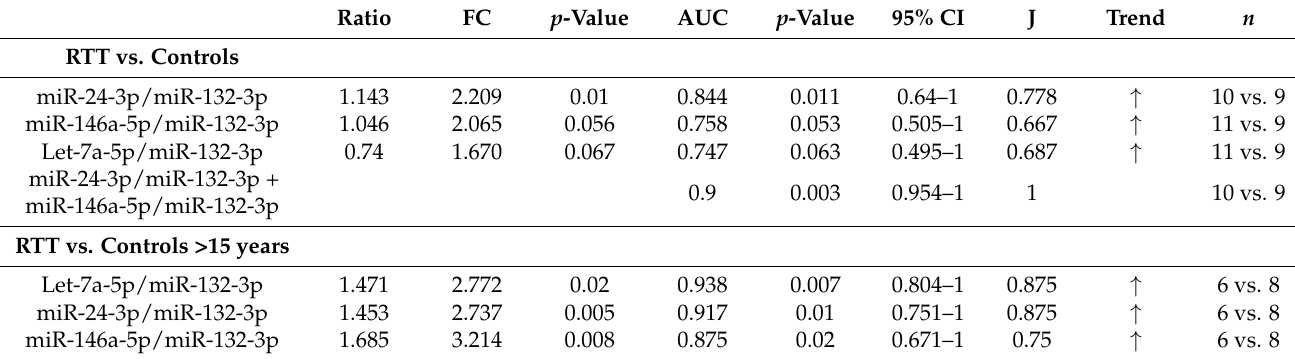
Figure 2. Potential microRNA (miRNA) biomarkers for RTT detection. ( A ) Heat map of Spearman correlation between miRNA expressions in plasma; 1 is positive correlation, 0 no correlation and − 1 is negative correlation. Statistically significant correlations ( p < 0.05) are black boxed. ( B ) Graph showing changes in miR-483-5p/miR-16-5p expression with age. ( C ) Graphs showing changes in expression of Let-7a-5p/miR-132-3p, miR-24-3p/miR-132-3p and miR-146a-5p/miR-132-3p between controls and RTT patients, and ROC curves assessing biomarker performance. ( D ) Graphs showing changes in expression of Let-7a-5p/miR-132-3p, miR-24-3p/miR-132-3p and miR-146a-5p/miR-132-3p between controls and RTT patients over 15 years old and ROC curves assessing biomarker performance. miRNA ratio data presented as 2 ∆ ct . * p < 0.05, ** p < 0.01 significant differences Mann–Whitney U test. Table 4. Plasma miRNA ratios and performance as RTT